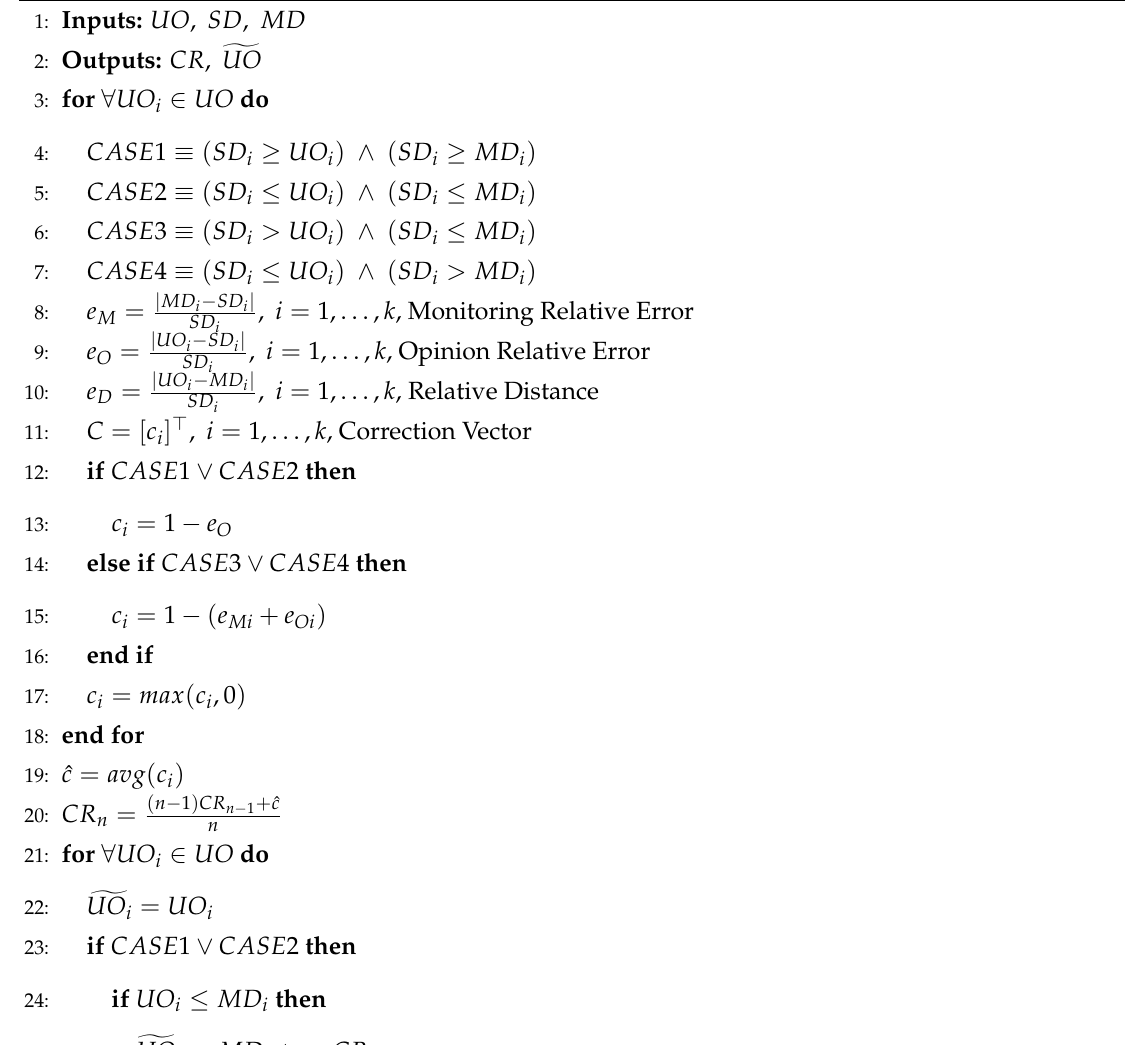
Algorithm 1 User credibility